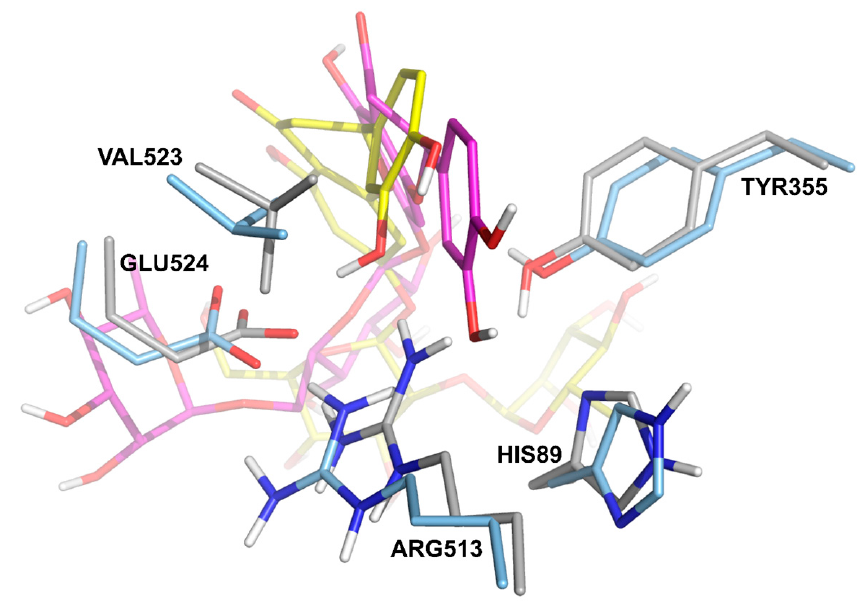
Figure 3. Molecular dynamics snapshots (at 6 ns simulation time) of ERI (magenta sticks) in complex with COX-2 (cyan sticks) and of NER (yellow sticks) in complex with COX-2 (gray sticks).